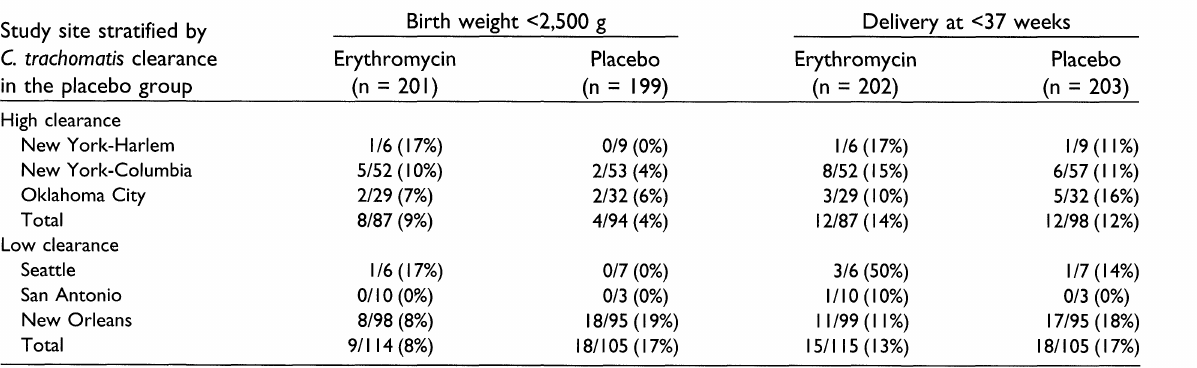
TABLE 4. Stratification of trial outcome by treatment and study center Study site stratified